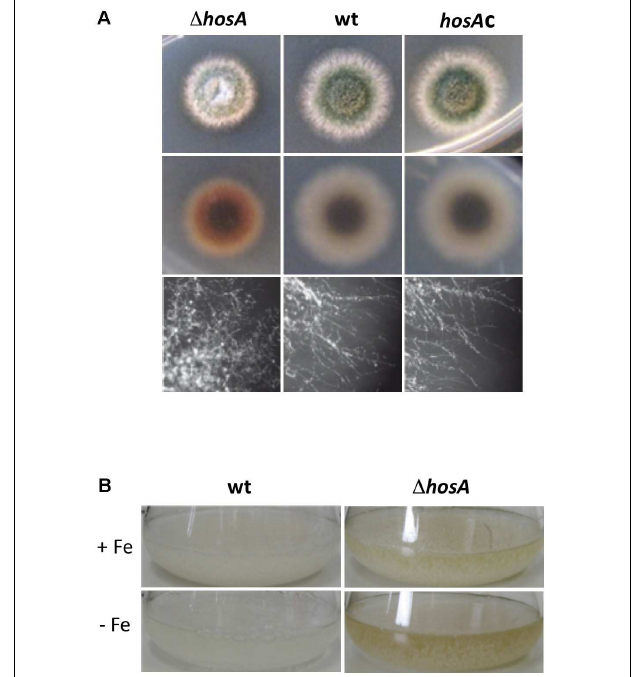
FIGURE 1 | Phenotype of hosA knock out strains compared to wildtype and hosA -complemented controls. Strains were grown for 48 h at 37 ◦ C on minimal medium before colonies were assessed regarding to their size and color (top view and bottom view of the plates). Moreover, hyphal growth was microscopically surveyed at a magnification of 400 × (lower row) (A) . Color of the growth medium of hosA mutants grown in submerged culture for 24 h in GMM with ( − Fe) or without (+Fe) iron starvation was assessed and compared to wt cultures (B)